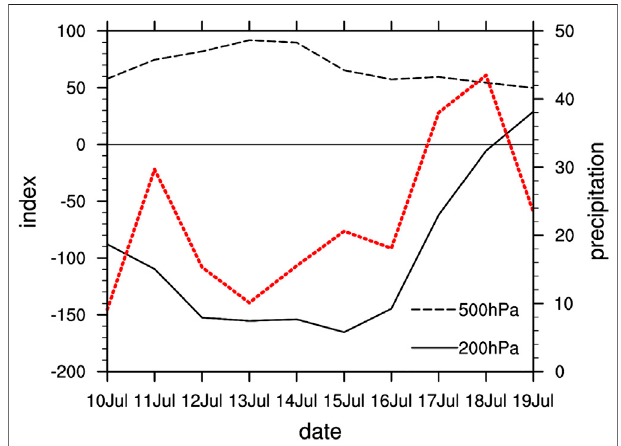
FIGURE 5 | Daily variation of I SR (black solid line, unit: gpm), I PJ (black dotted line, unit: gpm) and precipitation (red dot line, unit: mm) in the YHB